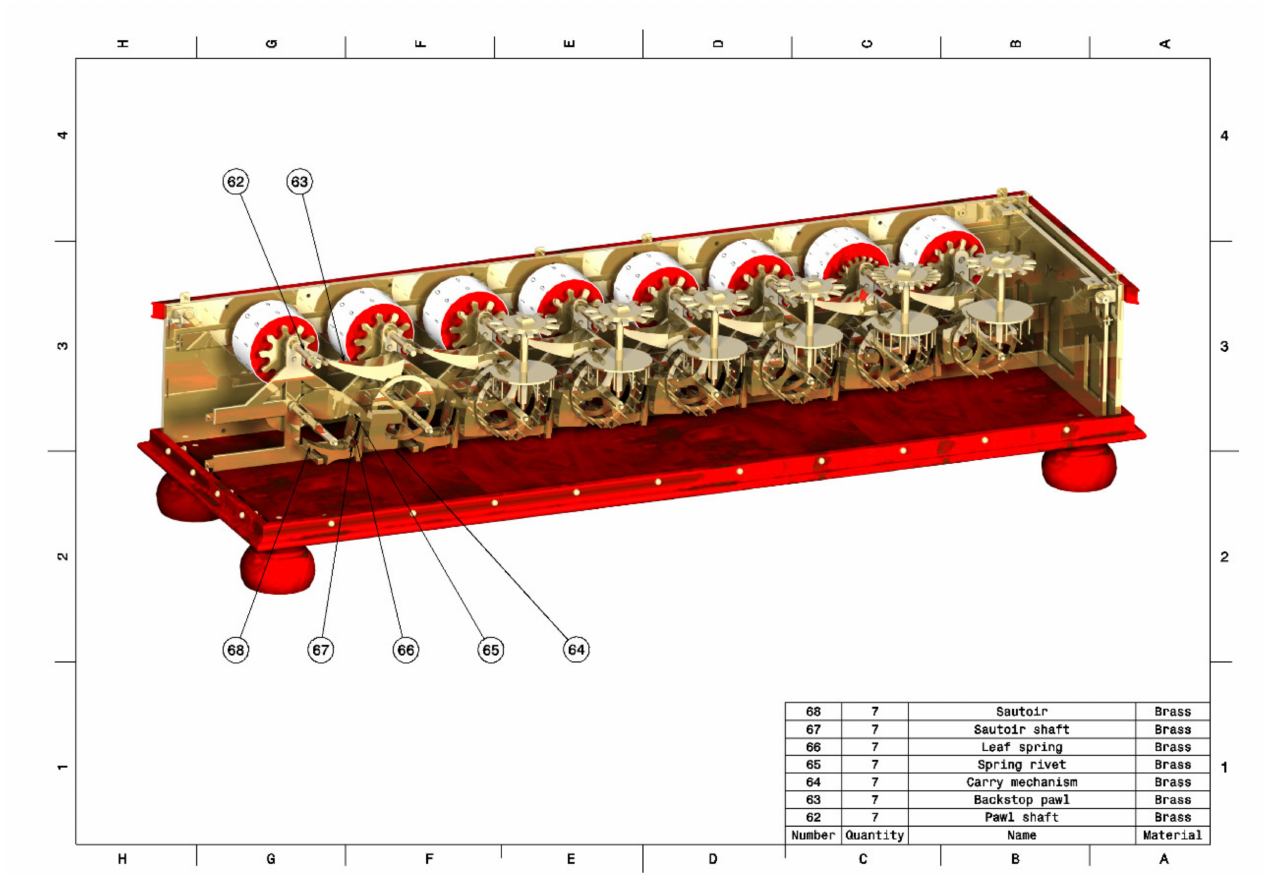
Figure 4. Assembly plan of the interior of the Pascaline with added transparency of input wheels and accumulators of the highest levels (Elements